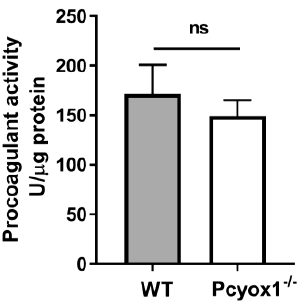
Figure 2. Procoagulant activity of WT and Pcyox1 − / − mice. Carotid artery procoagulant activity of WT and Pcyox1 − / − mice. n = 15 mice/group. Data are shown as mean ± SEM. ns = not significance at Mann-Whitney U-test.